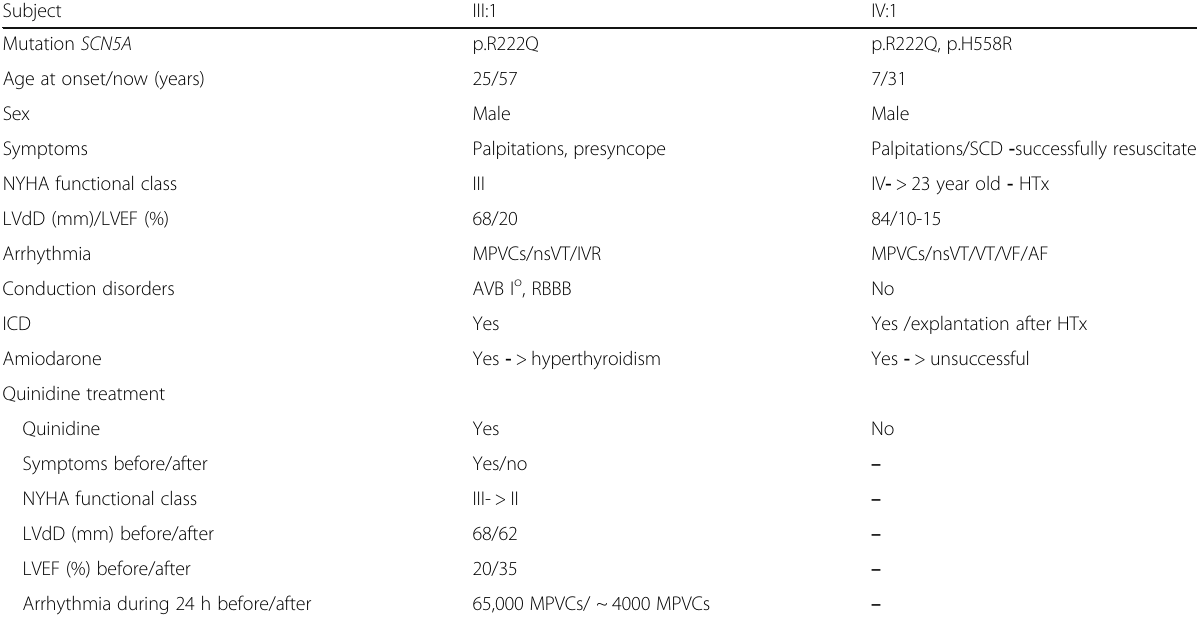
Table 1 Clinical characteristics of living affected family